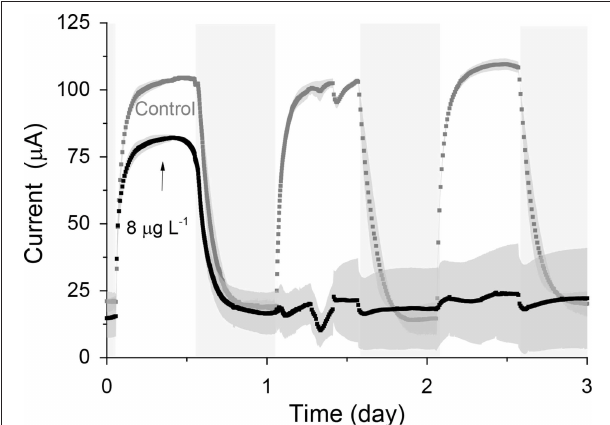
FIGURE 5 | Response of p-MFC GF to 8 µ g L − 1 of atrazine. The arrow indicates the point of atrazine injection. Shadowed areas indicate the operation during the dark cycle. Data is the average of two replicates. Error bars represent the absolute error between the two